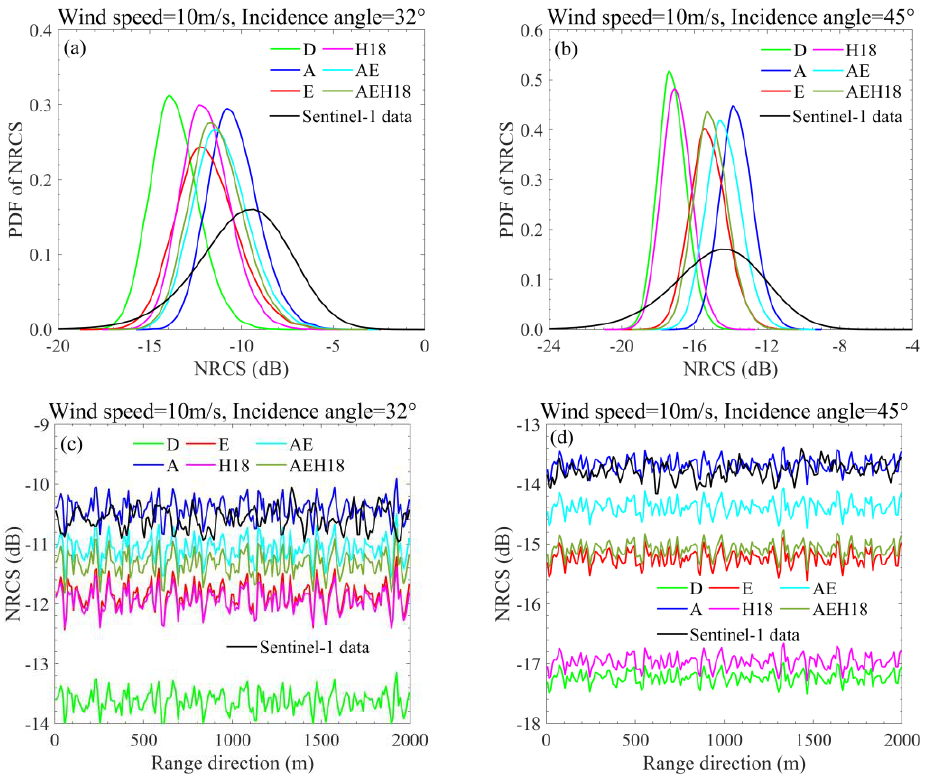
Figure 6. Examples of probability density functions of scattering and scattering profile predicted by the conventional TSM based on six wave spectra and their comparison with the Sentinel-1 data for the wind speed of 10 m/s at the incidence angle of 32° and 45° in the upwind direction. Curves for the different wind wave spectra are the same as those in Figure 4, and dark curves indicate Sentinel-1 data. ( a ) Pdfs for NRCSs at a 10 m/s wind speed and 32° incidence angle; ( b ) pdfs for NRCSs at a 10 m/s wind speed and 45° incidence angle; ( c ) profiles of NRCSs at a 10 m/s wind speed and 32° incidence angle; ( d ) profiles of NRCSs at a 10 m/s wind speed and 45° incidence angle.